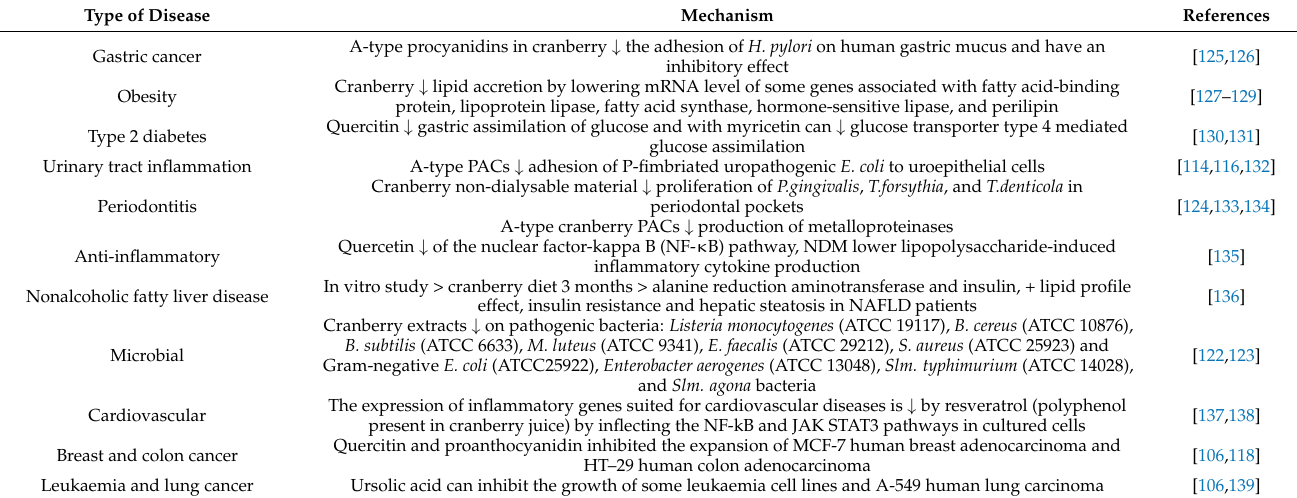
Table 5. Prevention of different types of diseases with cranberry consumption and